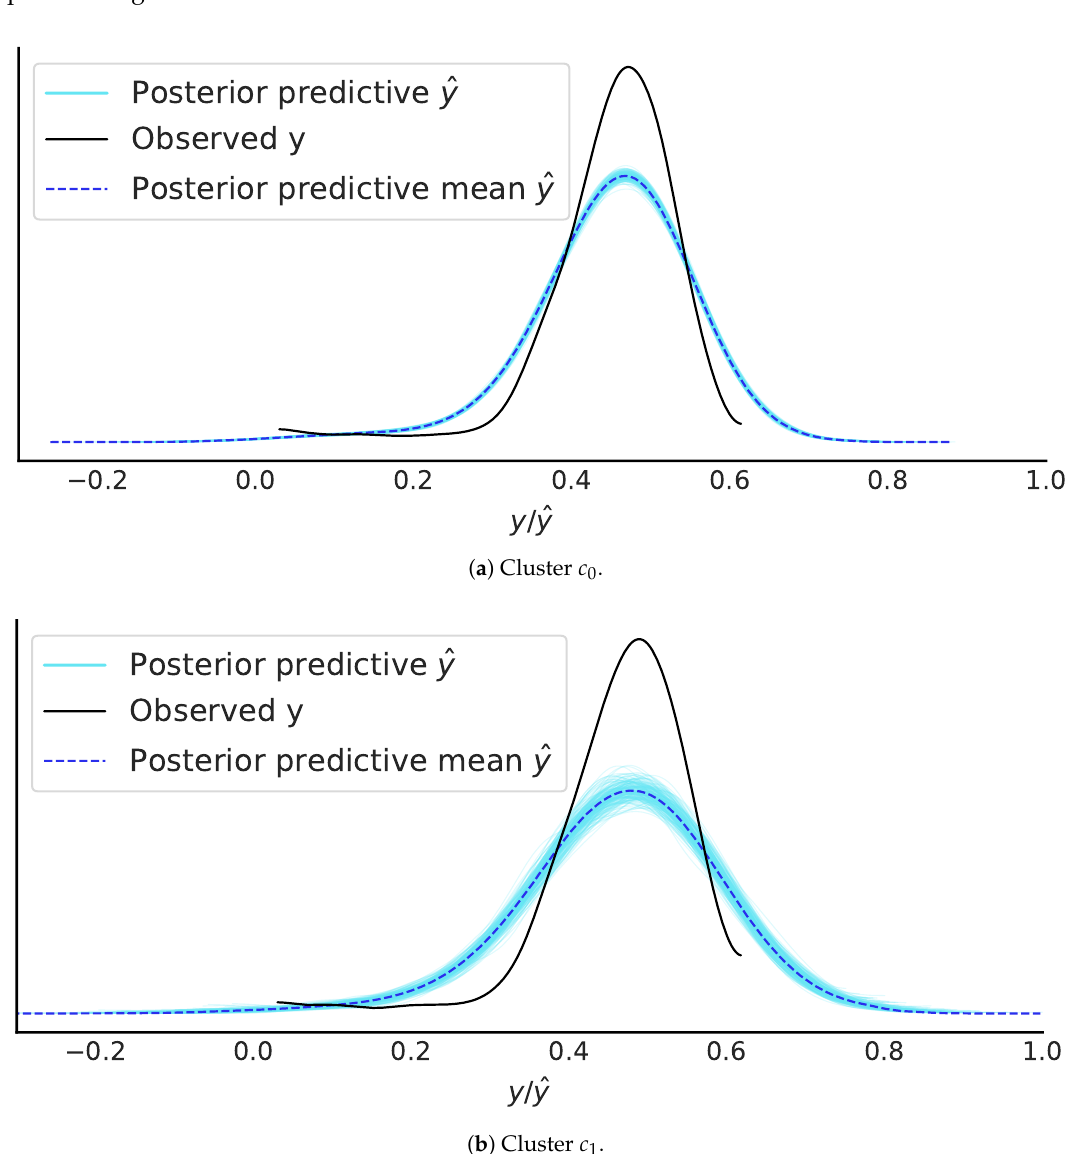
Figure 5. Posterior predictive check of the model output prediction ˆ y with 200 samples drawn from the posterior distribution. The plot was generated using the ArviZ library